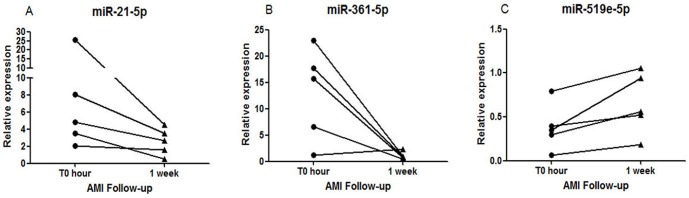
The follow-up expression of circulating miRNAs.Blood samples from 5 AMI patients who received PCI treatment were collected at 1 week after admitted to hospital. The follow up expressions of circulating (A) miR-21-5p, (B) miR-31-5p, and (C) miR-519e-5p in AMI patients after receiving medical treatment. Data are presented as mean ± SEM.